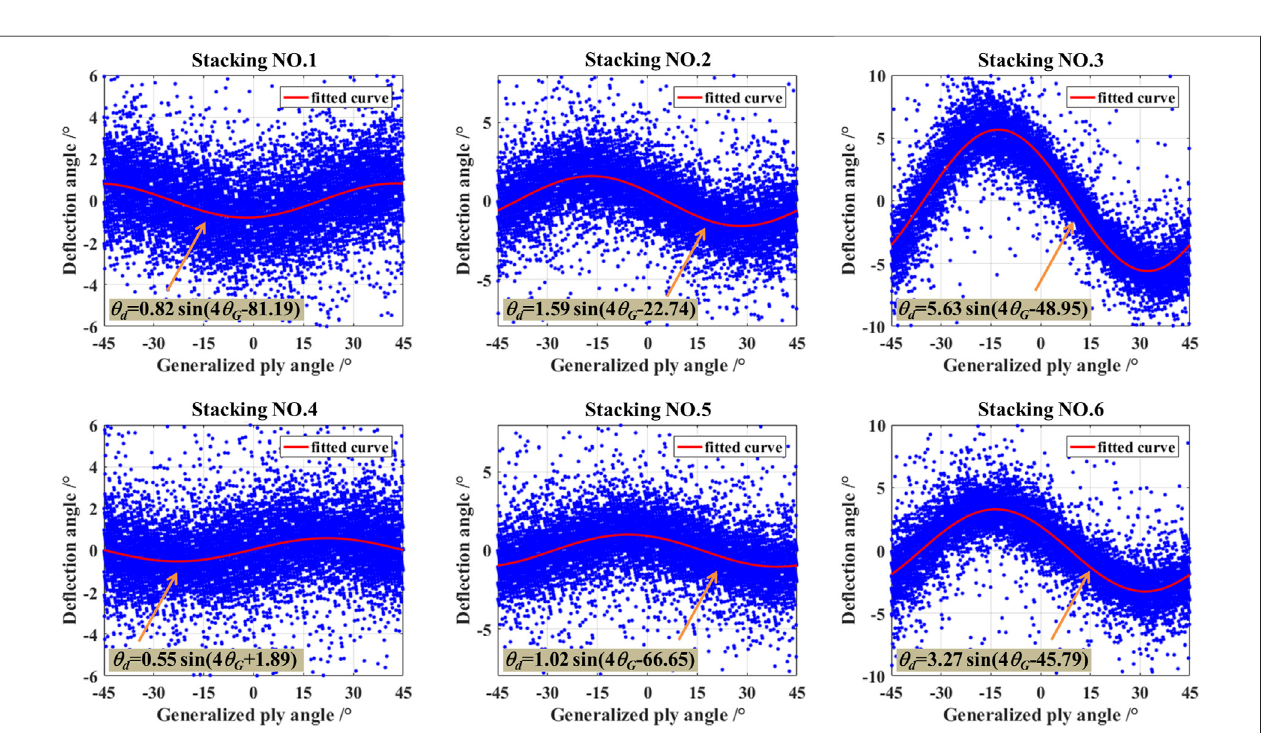
FIGURE 6 | Point diagrams and fi tting curves (including fi tting functions) of the de fl ection angle versus the generalized ply angle for Stacking Nos. 1 – 6.